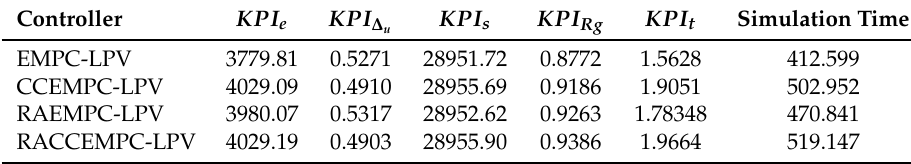
Figure 7. Evaluation of system reliability and accumulated economic cost. Table 4. Comparison of control